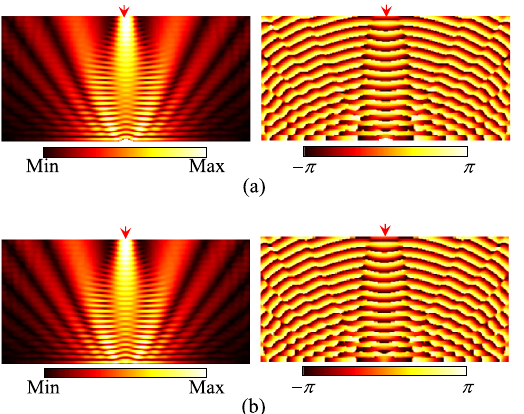
Fig. 13. Calculated complex voltage distributions for the case with the normal incident wave at the wavelength l g = 12 D d . Left: Amplitude. Right: Phase. (a) With the original bump. (b) With the bump illusion medium.